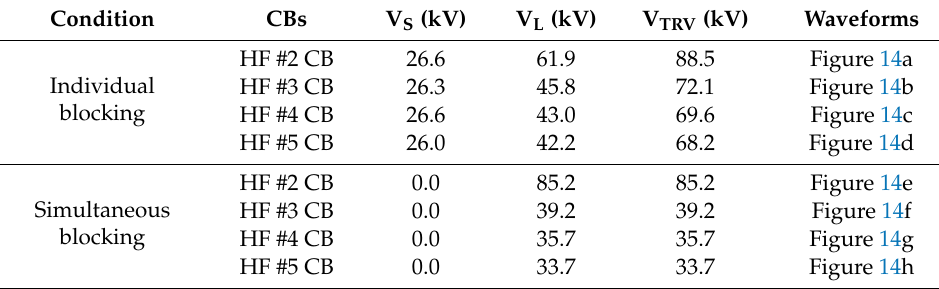
Table 4. Transient recovery voltage for Case 2.